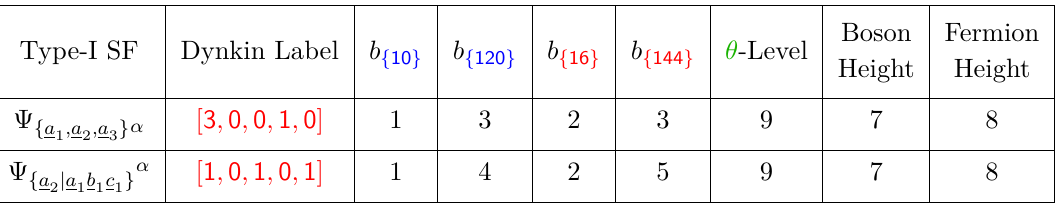
Table 4 . Type-I Superfield Contributions to Bosons at Level-16 & Fermions at Level-17 in Type- IIA Scalar Superfield Decomposition.